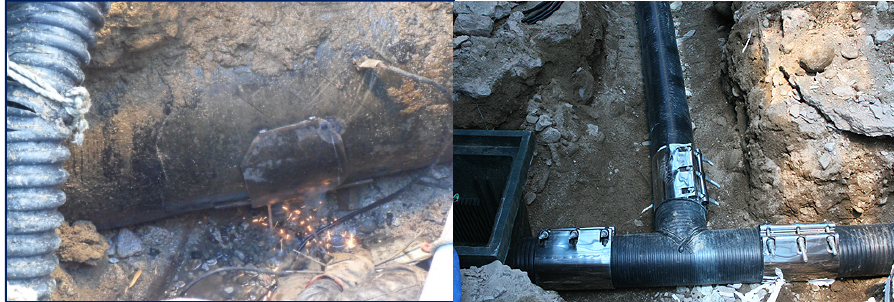
Figure 1. Failure of underground pipelines.